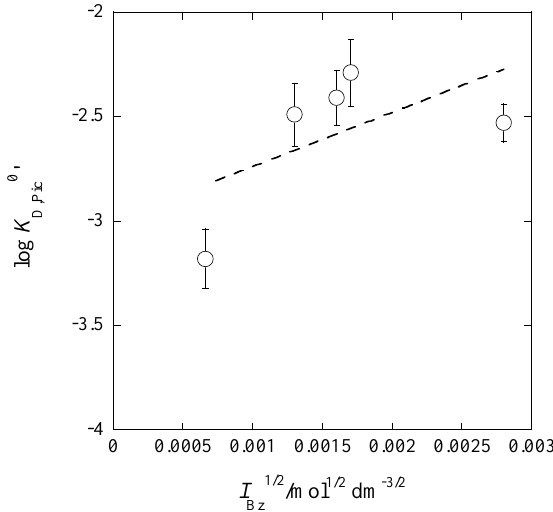
Figure 9. Plot of log K D,Pic0 ′ versus I Bz1/2 based on Equation (17) for the Pb(II) extraction with Cd(NO 3 ) 2 and B18C6 into Bz. The symbol K D,Pic0 ′ was defined as K D,Pic / y Pic . The error bars in the figure are those of the log K D,Pic values.